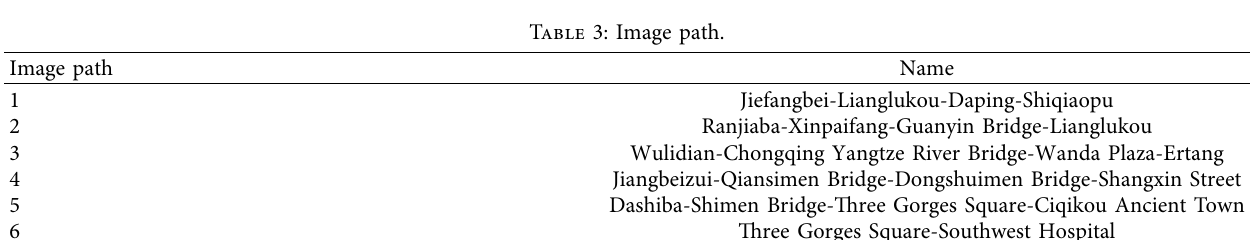
Table 3: Image path.